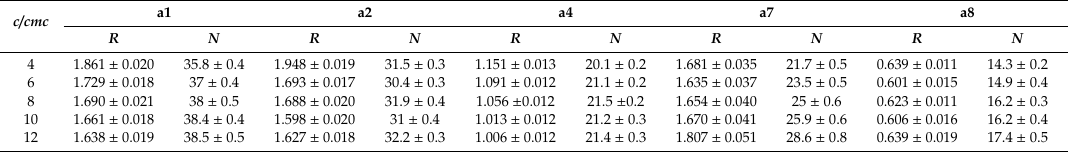
Figure 1, micelle aggregation number values for diamide surfactants a1 to a8 almost do not depend on surfactant concentration c / cmc . This implies the formation of stable spherical micelles with a constant aggregation number for diamide geminis a(s) , s = 1-8 in the concentration range 4 × cmc to 12 × cmc . In Figure 2A, the plot of N vs. spacer length s is shown for three di ff erent surfactant concentrations c / cmc = 4, 8,